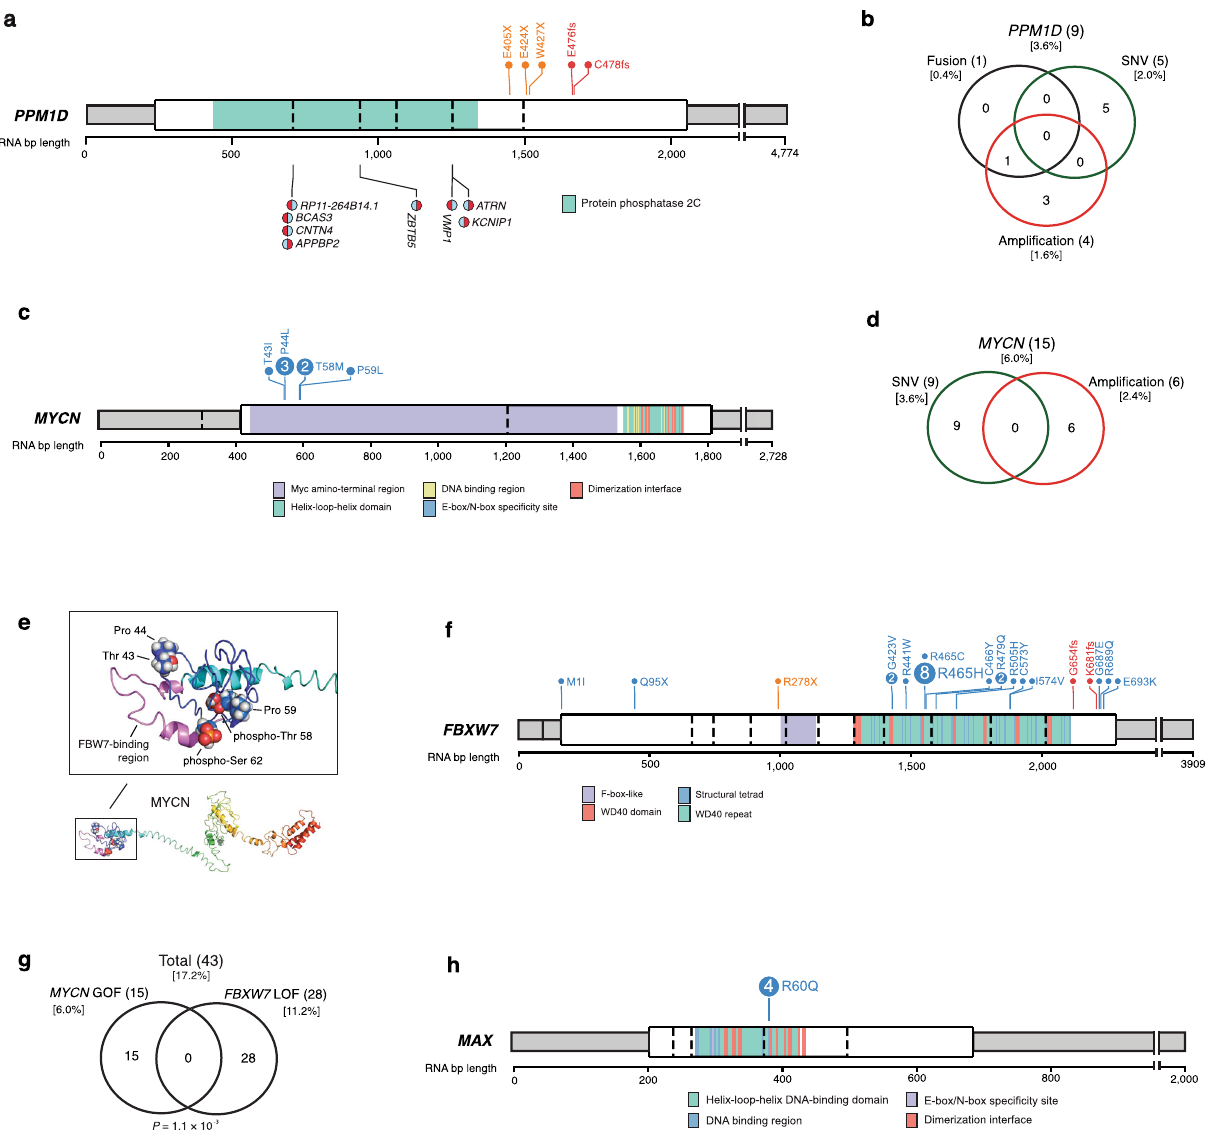
Fig. 3 Alterations in cell cycle control genes. a , b Gene-level summary of ( a ) PPM1D events and ( b ) their overlaps. c Gene-level summary of MYCN events. Only mutations in the canonical isoform NM_005378 are shown. d Overlap of MYCN fusion, ampli fi cation, and SNV events. e Structural model of MYCN highlighting positions affected by hotspot mutations (blue) near the FBWX7 protein binding region (purple), and phospho-degron positions (red). f Gene-level summary of FBXW7 events. g Mutual exclusivity of MYCN gain-of-function (GOF) and FBXW7 loss-of-function (LOF) events. P -value calculated using the DISCOVER package. GOF and LOF events include both high-level CNA and mutation events. h Gene-level summary of MAX